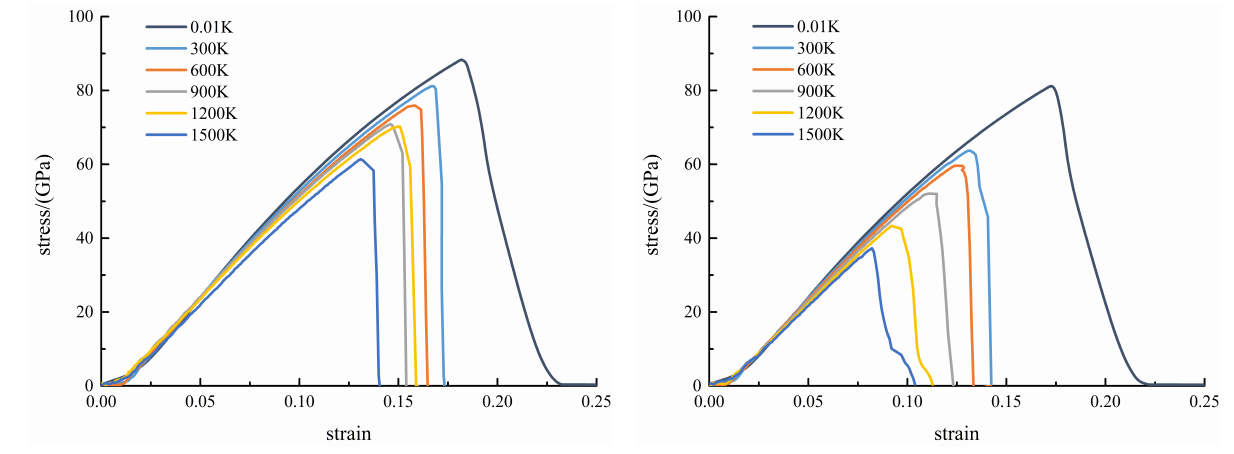
Figure 2: Stress-strain curve of perfect BNNSs.